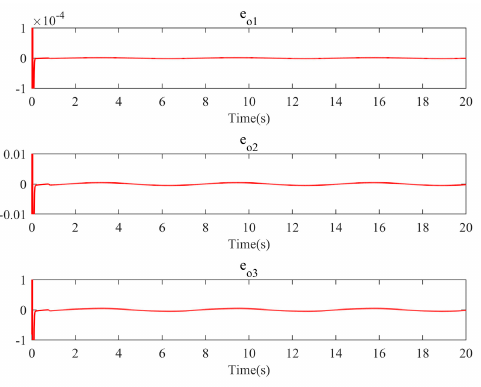
Figure 15. Observation curves of LESO for system state and total disturbance in the inverted pendulum system.